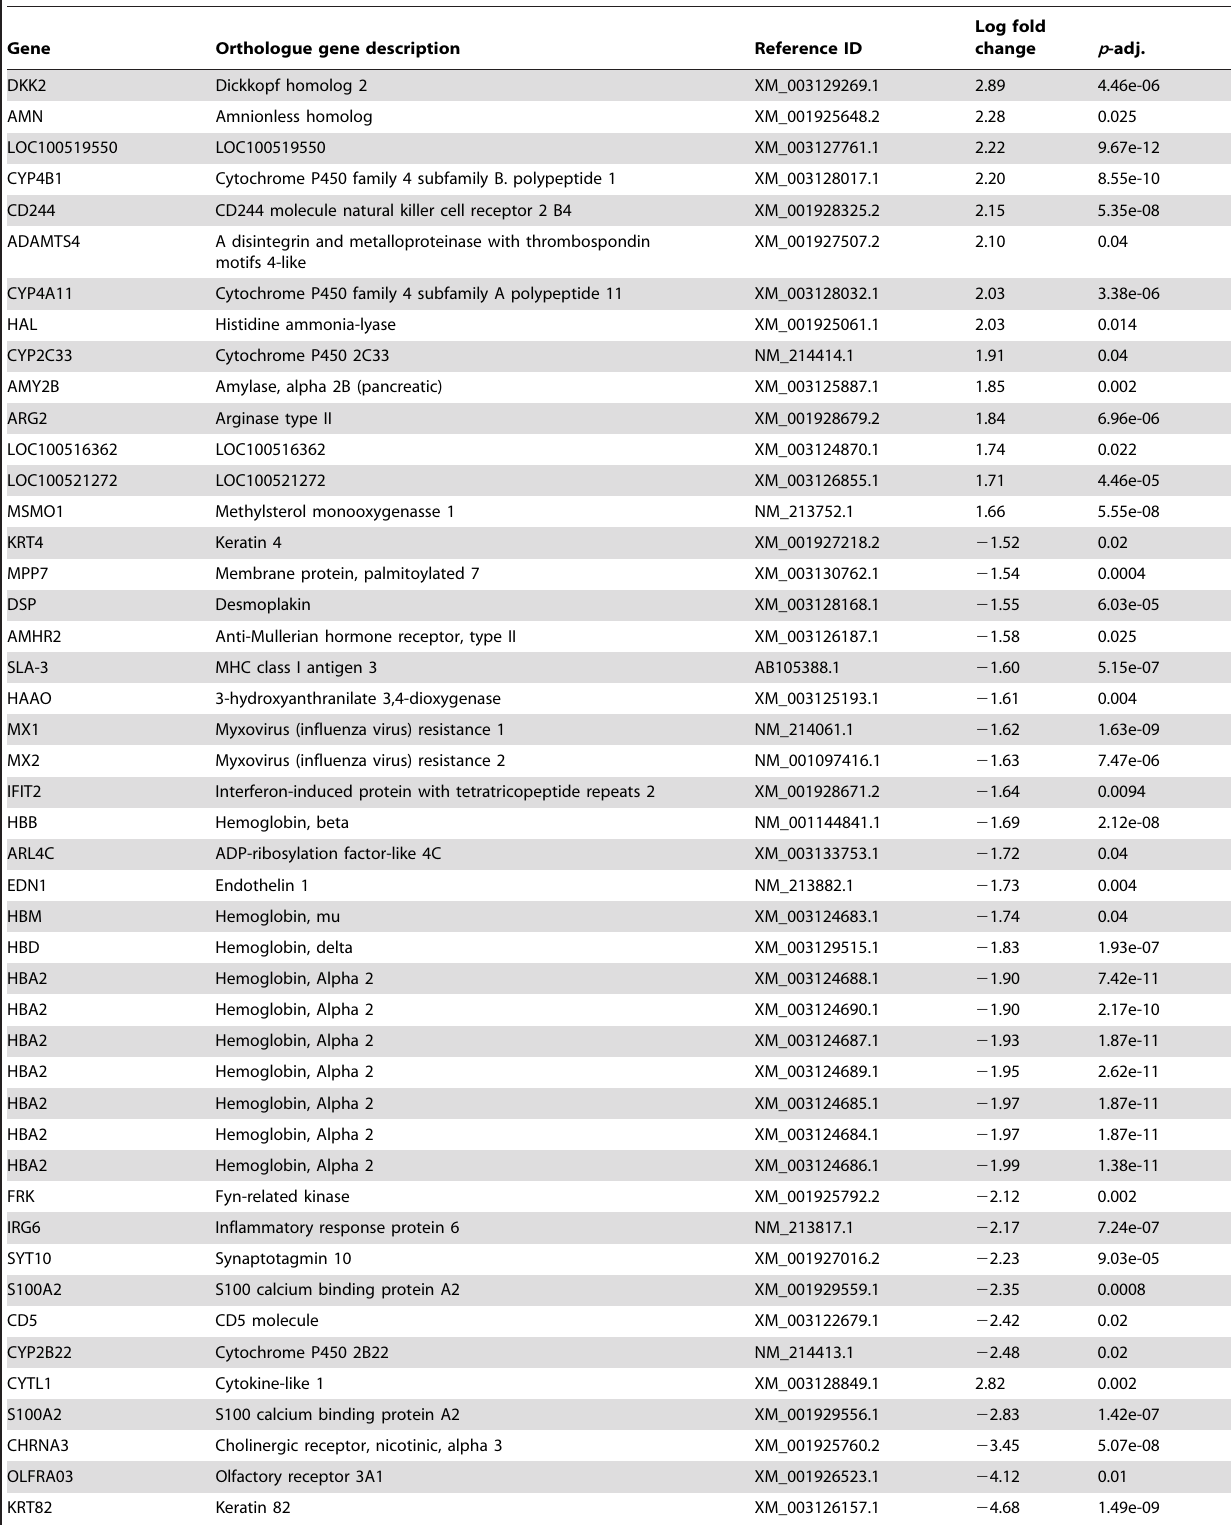
Table 3. Differentially expressed genes in testis androstenone samples.